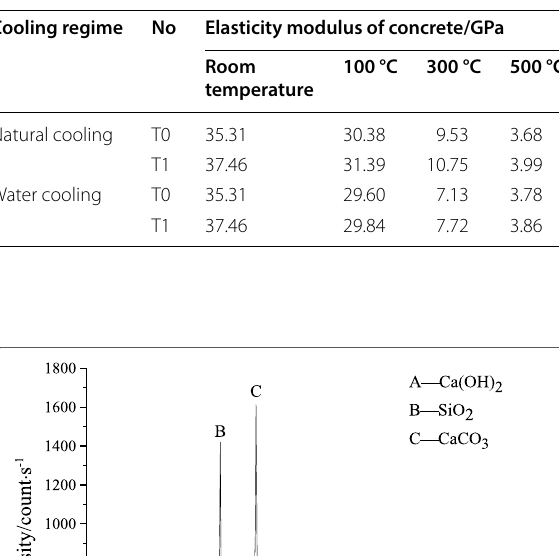
Table 6 Elasticity modulus of concrete T0 and T1 after elevated temperature.